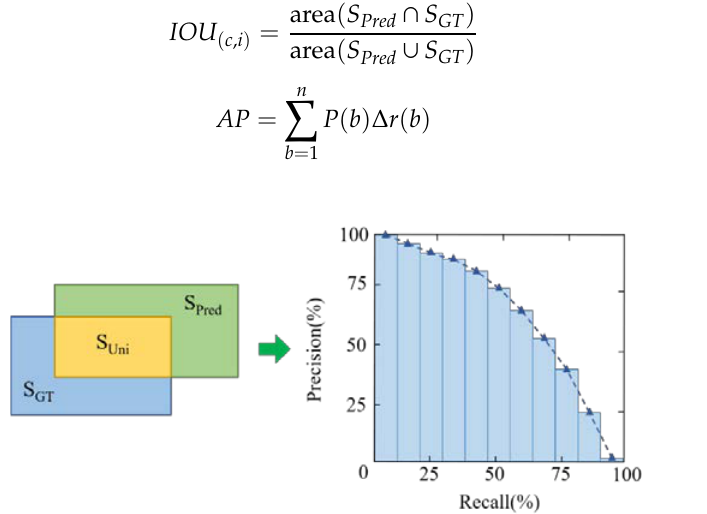
Figure 9. Metrics for performance of imbalanced detection.